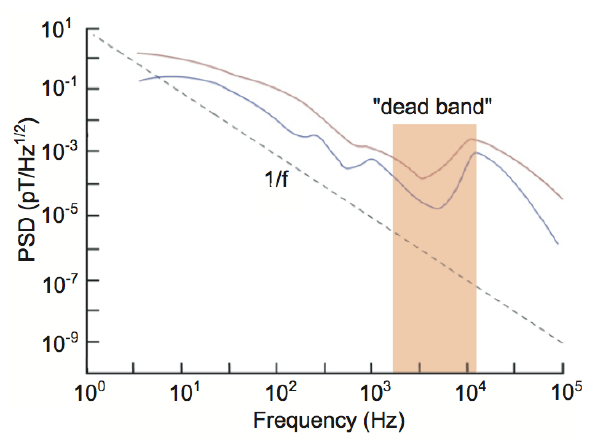
Figure 2. PSD of the ELF-VLF background mid-latitude noise. The blue and red lines indicate minima and maxima,